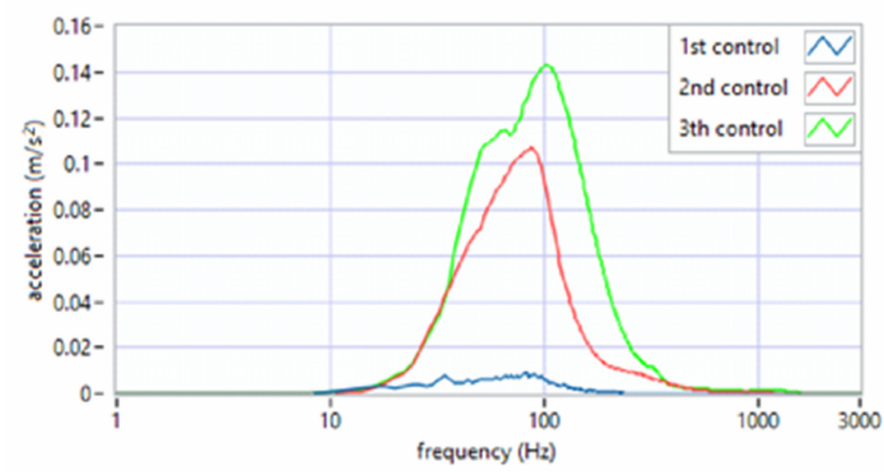
Figure 10. Average spectrum of slow protruding (SP)—left side: 1st, 2nd, 3rd period.